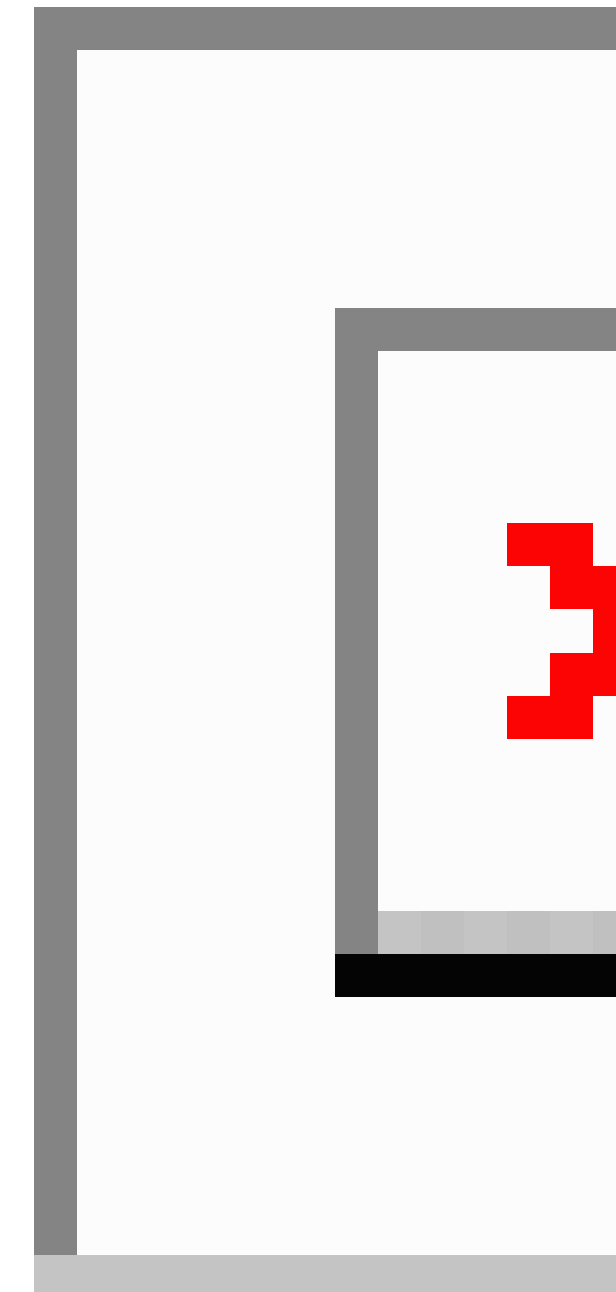
Figure 1. Flow Diagram of Study